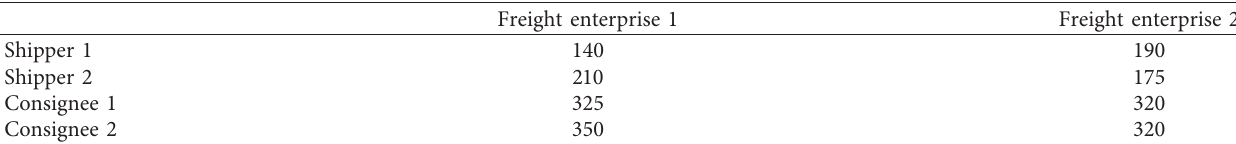
Table 3: The distance between nodes in the small bulk cargo transport network (km).